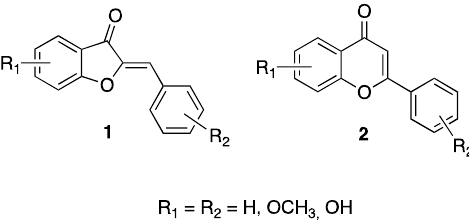
Figure 1. General structures of aurones 1 , and flavones, 2 .